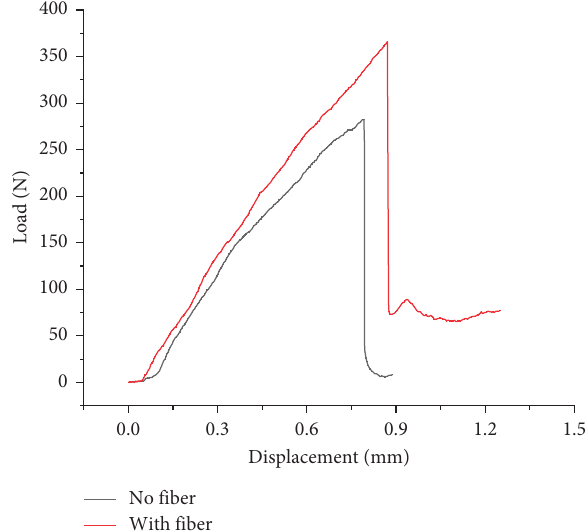
Figure 20: The bending load and displacement curves.